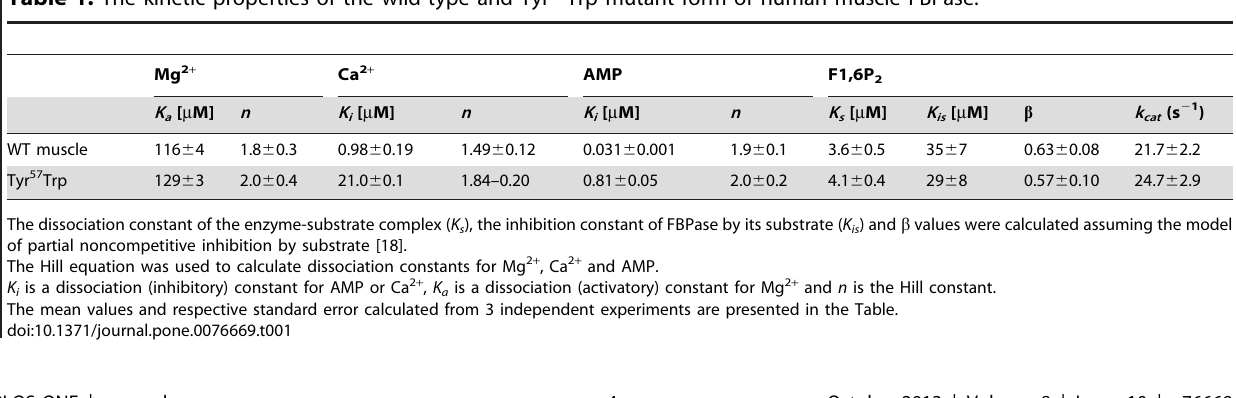
Table 1. The kinetic properties of the wild-type and Tyr 57 Trp mutant form of human muscle FBPase.